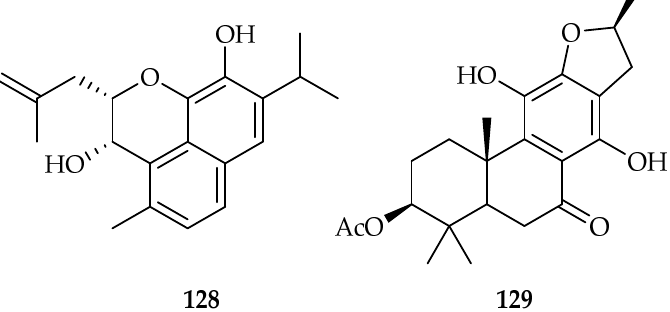
Figure 53. Structures of ceratodiol 128 [80] and 3-acetoxylteuvincenone G 129 [81].